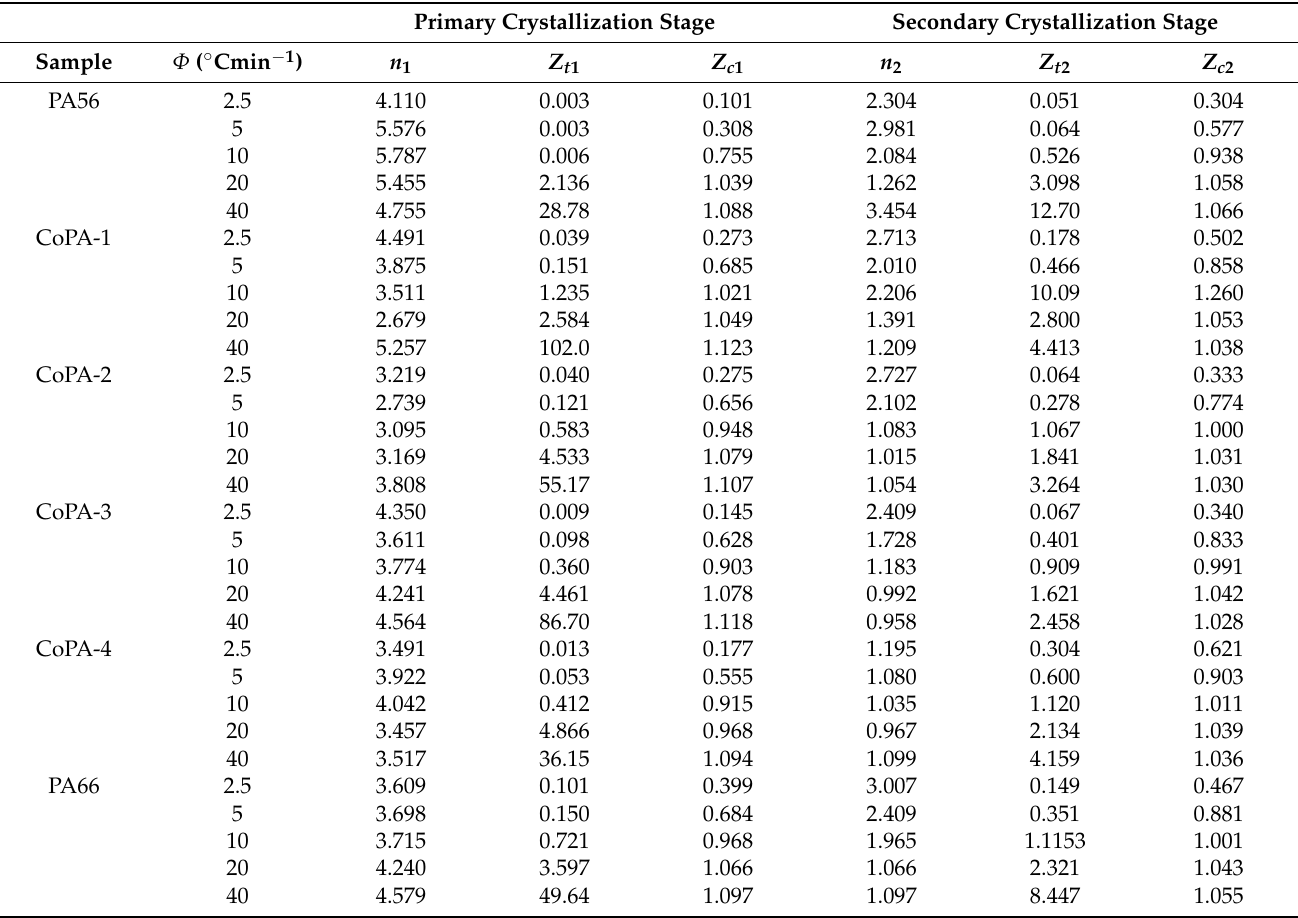
Table 6. The values of n , Z t and Z c from the Avrami equation at the two stages of nonisothermal